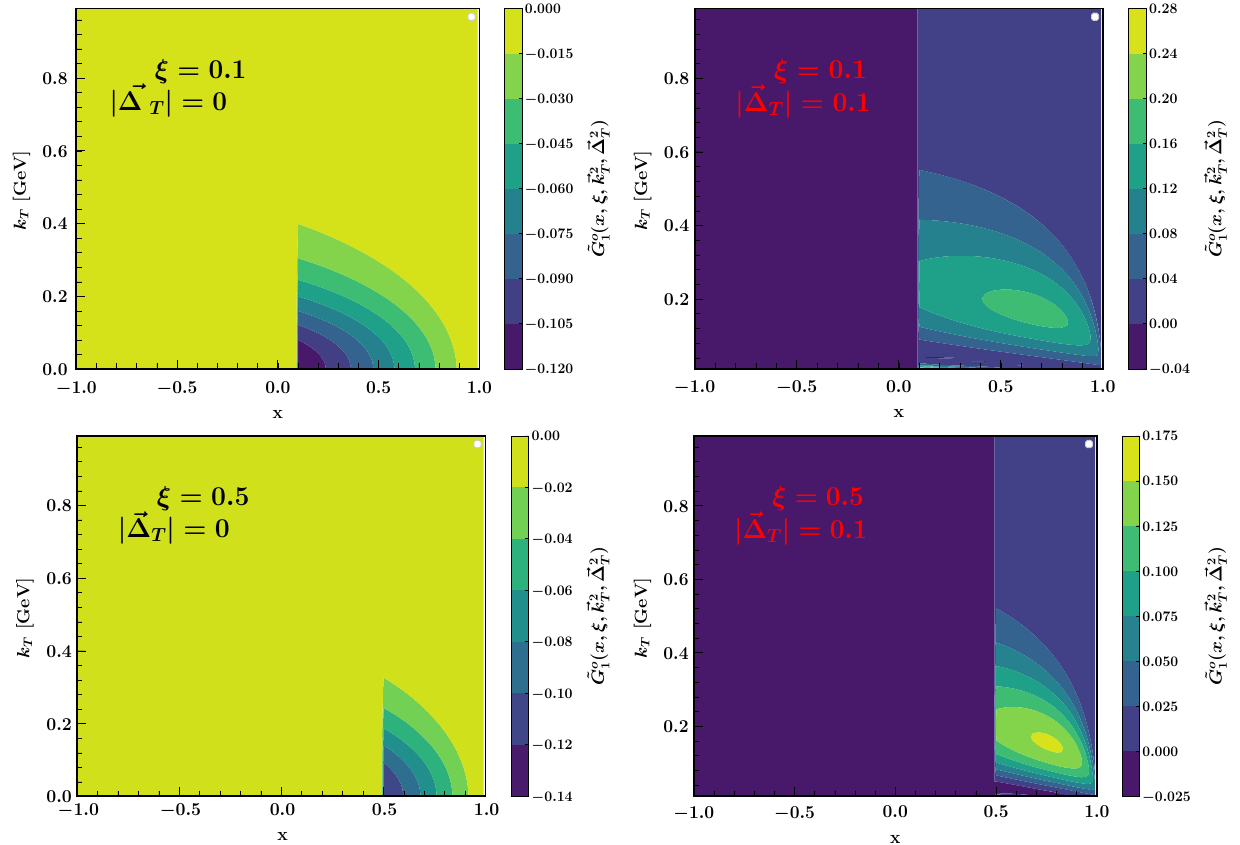
( x ,ξ, (cid:2) k 2 , (cid:2) (cid:3) 2 ) as functions of x and |(cid:2) k T T 1